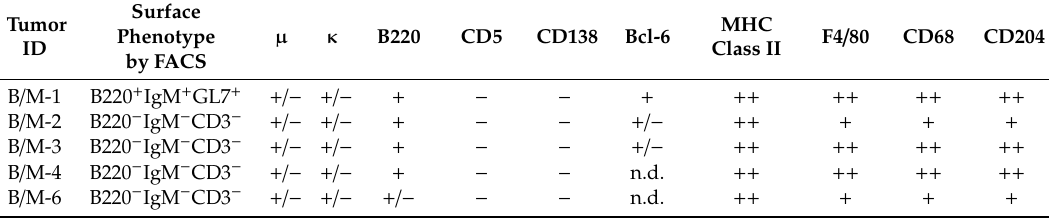
Table 2. Immunocytochemical analysis of Hodgkinoid lymphoma cell lines derived from Ig - ganp Tg